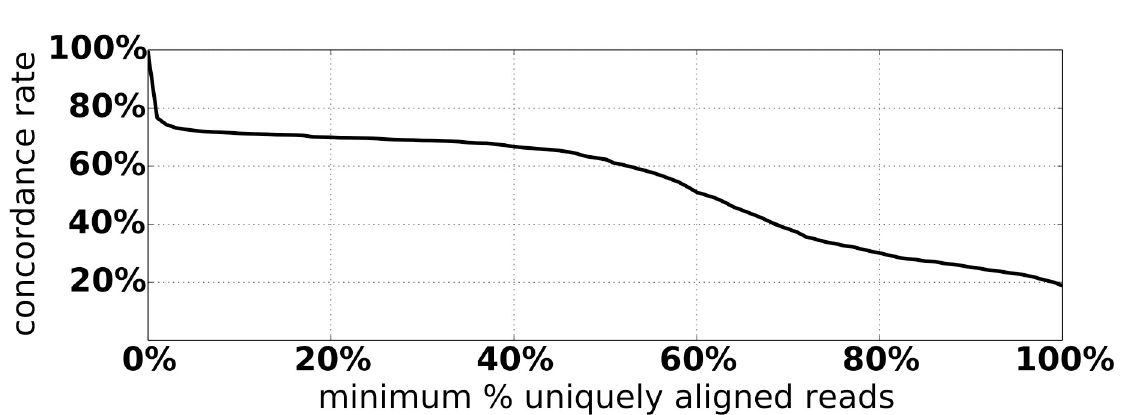
Fig 4. Concordance rate of Exogene and HIVID calls as a function of minimum allowable percentage of reads aligned with mapping quality 0.